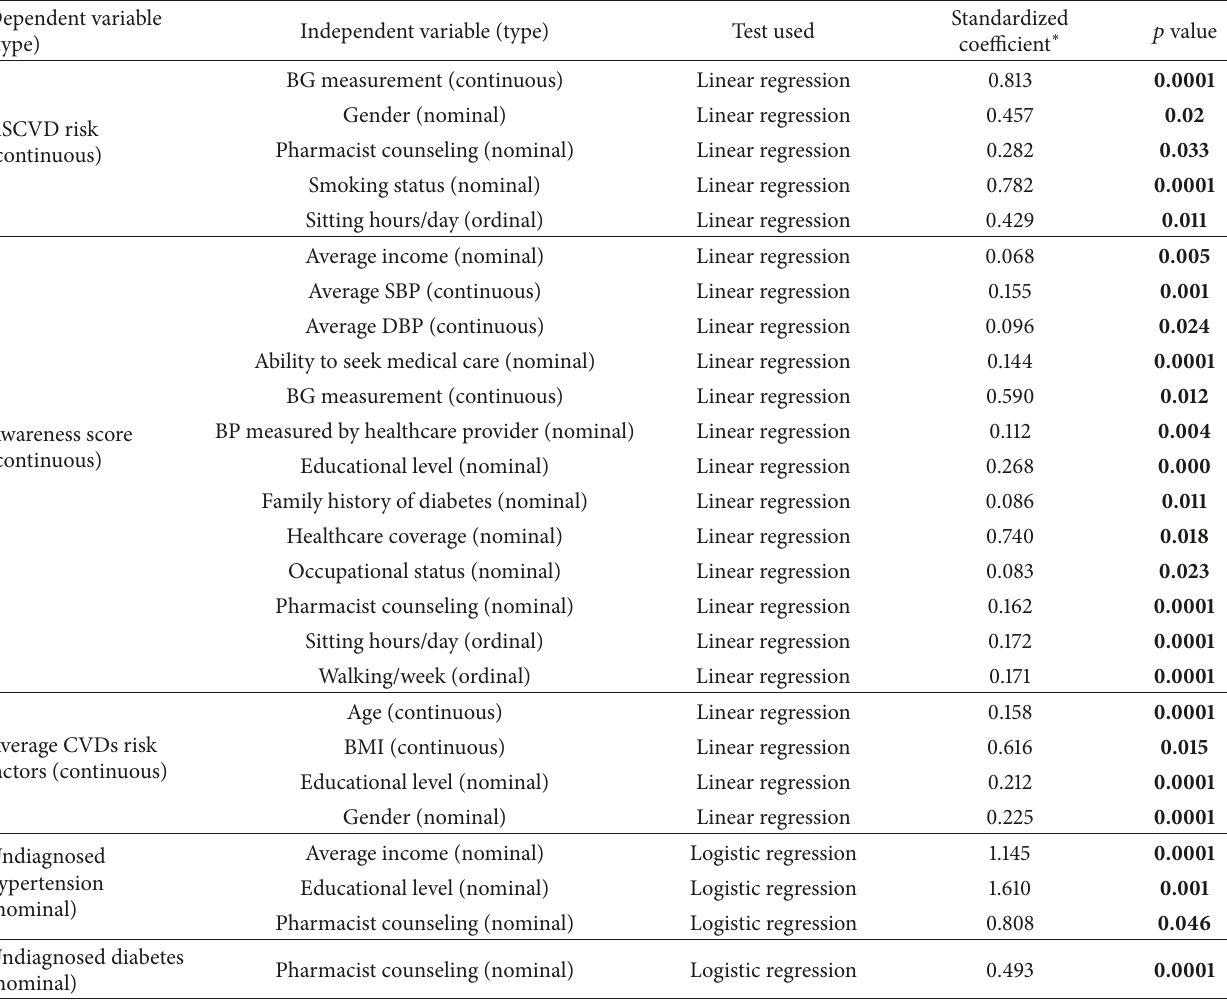
Table 4: Significant